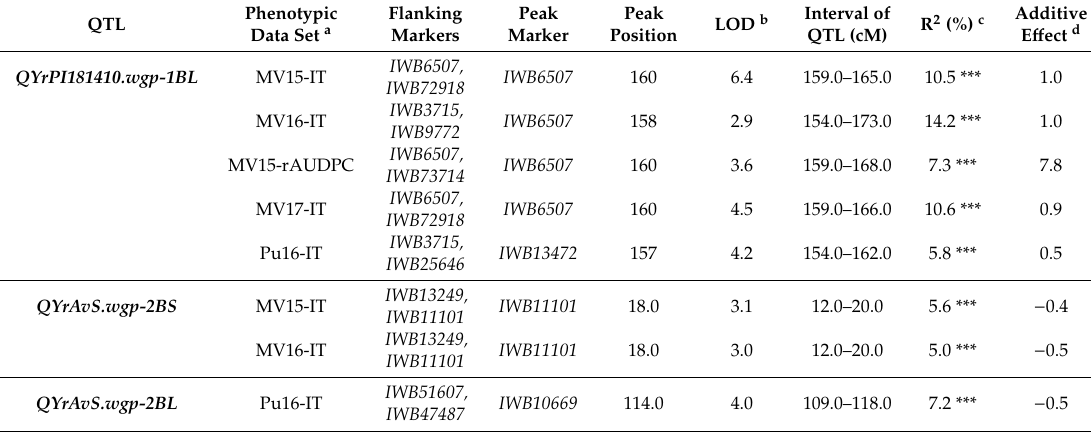
Table 5. Quantitative trait loci (QTL) associated with high temperature adult-plant resistance (HTAP) to stripe rust detected in wheat genotype PI 181410 and AvS using the recombinant inbred line population derived from AvS × PI